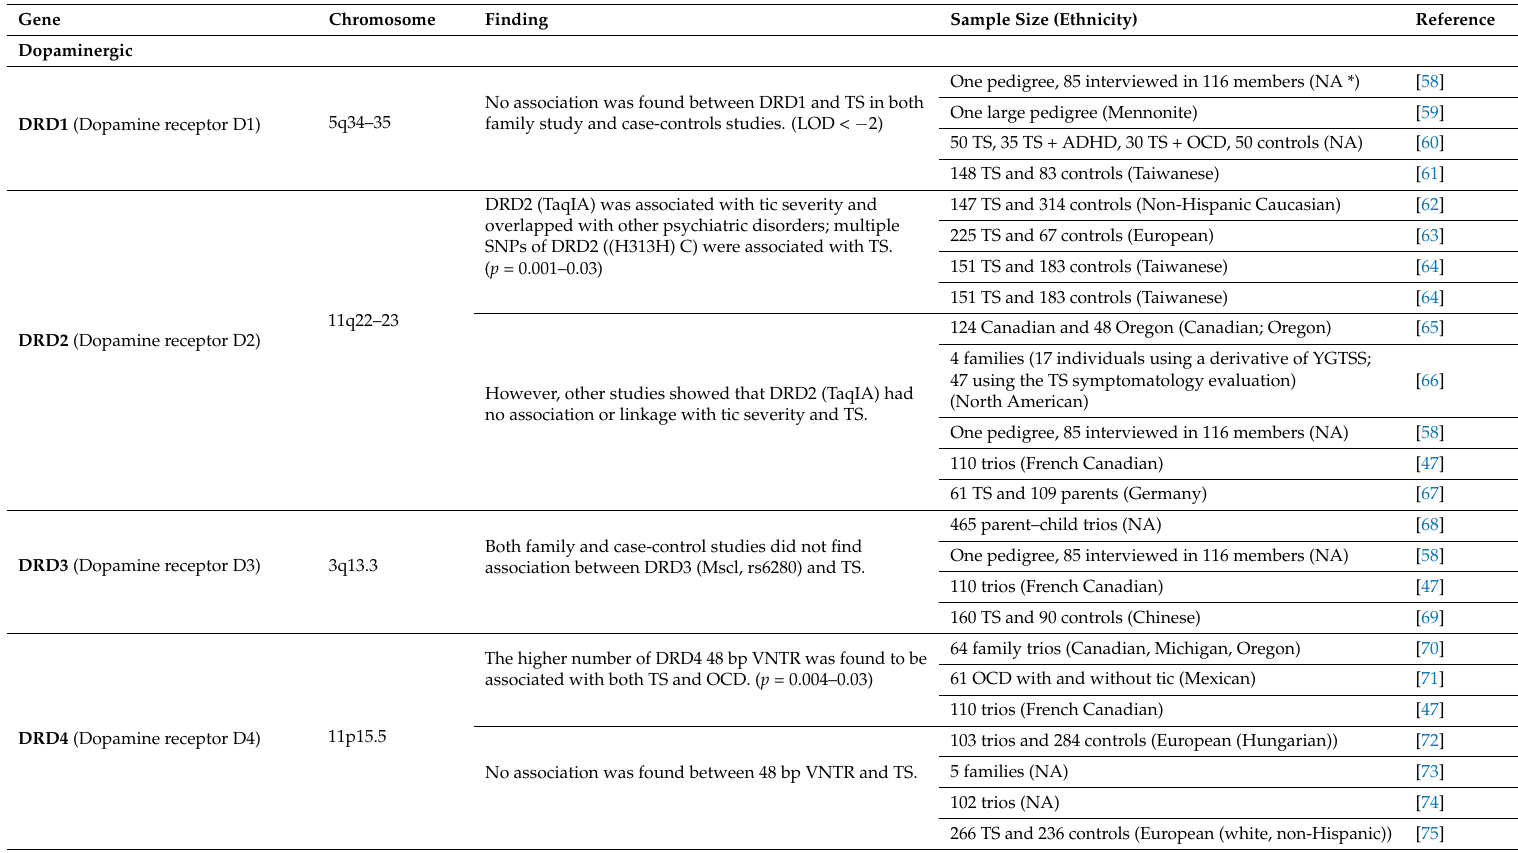
Table 1. Main findings of linkage and association studies of neurotransmitter genes in Tourette’s Syndrome